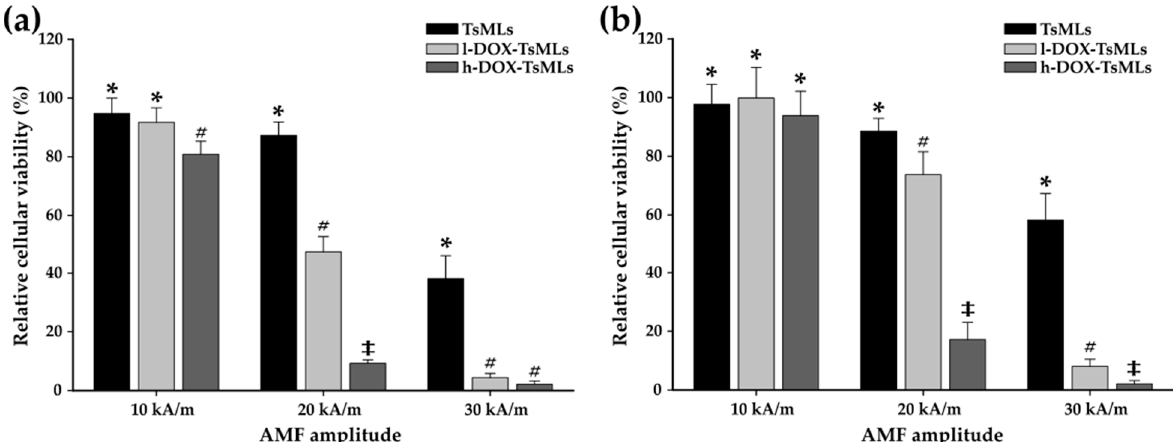
Figure 6. Cytotoxic effects of TsMLs with and without DOX, mixed with A549 cells were evaluated after a 30 min exposure to AMF of 355 kHz and amplitudes of 10, 20, and 30 kA/m. Cellular viability was measured using Alamar Blue ( a ) and Neutral Red ( b ) assays and presented as the mean ± SD of three biological replicates. Data are presented as relative values to their negative control (100%). Different symbols(*,#,‡) indicate a statistically significant difference between the groups (ANOVA + Holm-Sidak; p < 0.05).